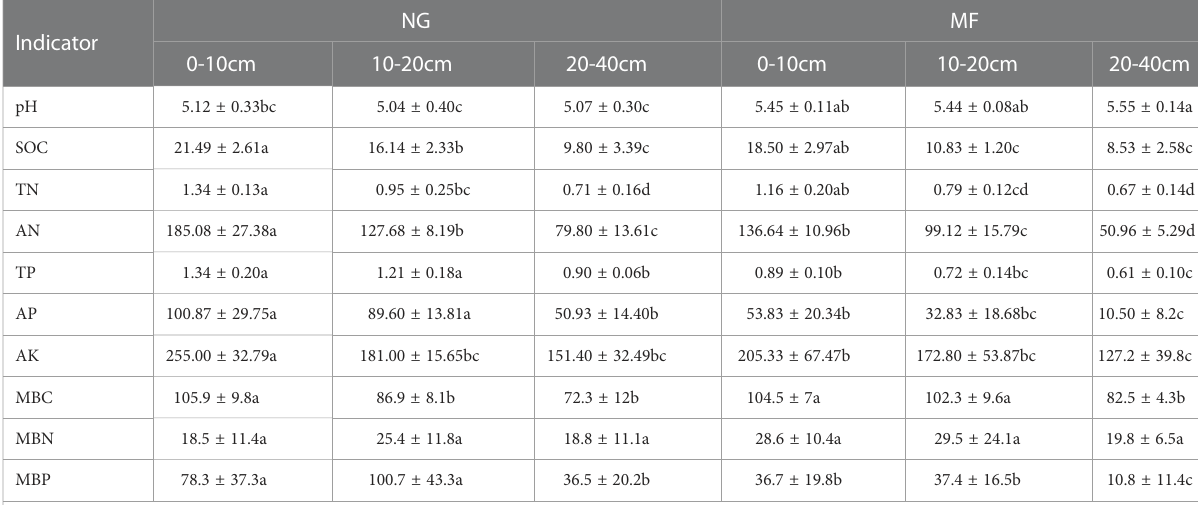
TABLE 1 Soil chemical characteristics of different soil layers (0 – 10 cm, 10 – 20 cm, and 20 – 40 cm) under different treatments (NG, natural grass; MF, planting ryegrass and mowing as